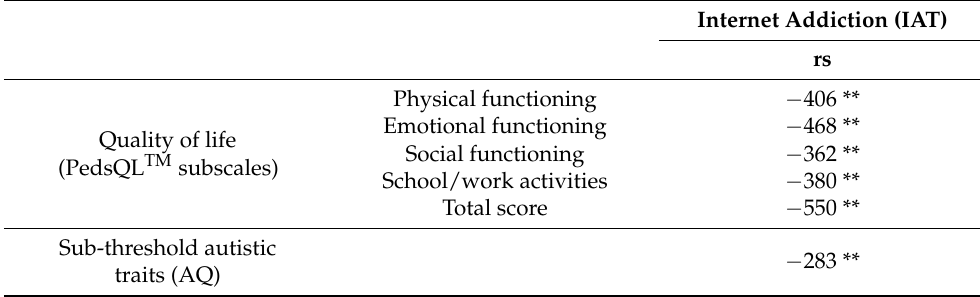
Table 3. Spearman’s correlations (rs) between quality of life (PedsQL TM subscales) and Internet addiction (as measures with IAT), and between quality of life (PedsQL TM subscales) and presence of sub-threshold autistic traits (as measured with AQ) in the whole sample (N =145). Internet Addiction (IAT) rs Physical functioning − 406 ** Emotional functioning − 468 ** Quality of life Social functioning − 362 ** (PedsQL TM subscales) School/work activities − 380 ** Total score − 550 ** Sub-threshold autistic − 283 ** traits (AQ)